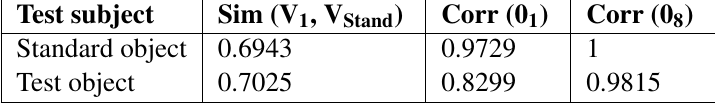
Table 4 Correlation parameters of left arm gesture (0–1